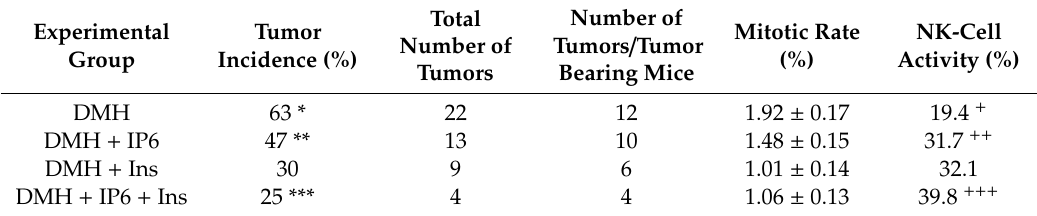
Table 1. Cancer inhibition by IP6 when combined with Ins in 1,2-dimethylhydrazine (DMH)-induced colon carcinoma in mice and on Natural Killer (NK)-cell activity. Number of Total Mitotic Rate Experimental Tumor Tumors / Tumor Number of (%) Group Incidence (%) Bearing Mice Tumors